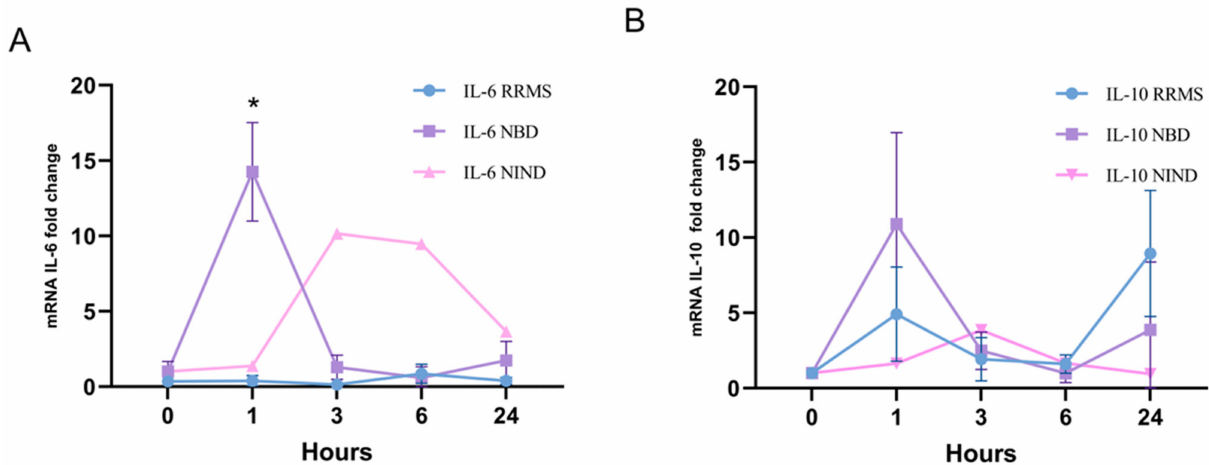
Figure 3. Dynamics of IL10 and IL6 expressions in RRMS and NBD patients. ( A ) IL6 induction in PBMCs of RRMS, NBD and NIND at 1, 3, 6 and 24 h following TLR9 ligation by CpG ODN2006. The results are mean ± SEM with * p ≤ 0.05 a minimum of three independent experiments. ( B ) IL10 induction by CpG in PBMCs of RRMS, NBD and NIND at 1, 3, 6 and 24 h following TLR9 ligation by CpG ODN2006. Statistical significance was assessed using nonparametric multiple t -test and Kruskal–Wallis